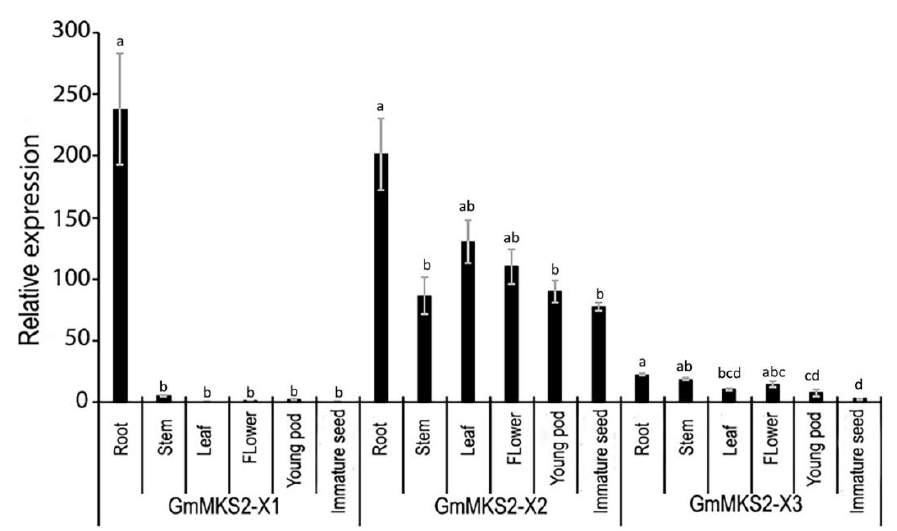
Figure 4. Relative expression levels of GmMKS2 transcripts in different tissues of G. max , determined by qRT-PCR. Expression values were normalized to those of cons6 (Genbank accession: NM_001254106.2 ) . Each value is the mean ± standard error (SE) from three biological replicates. Significant differences were assessed by one-way ANOVA followed by Tukey’s HSD test. Bars of the same transcript with different letters are significantly different ( p < 0.01).